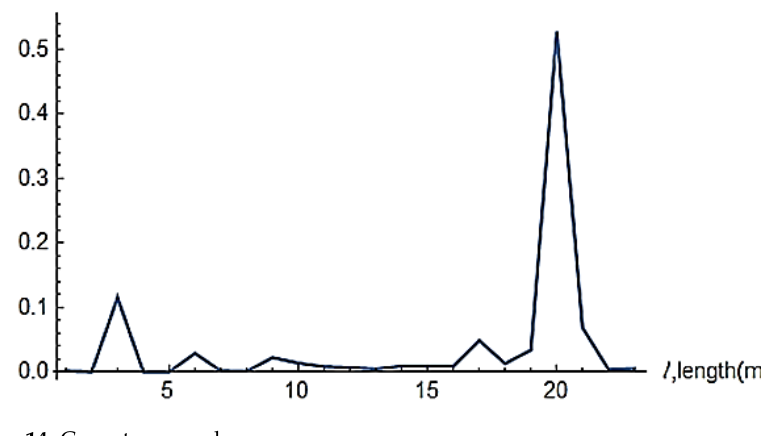
Figure 14. Curvature